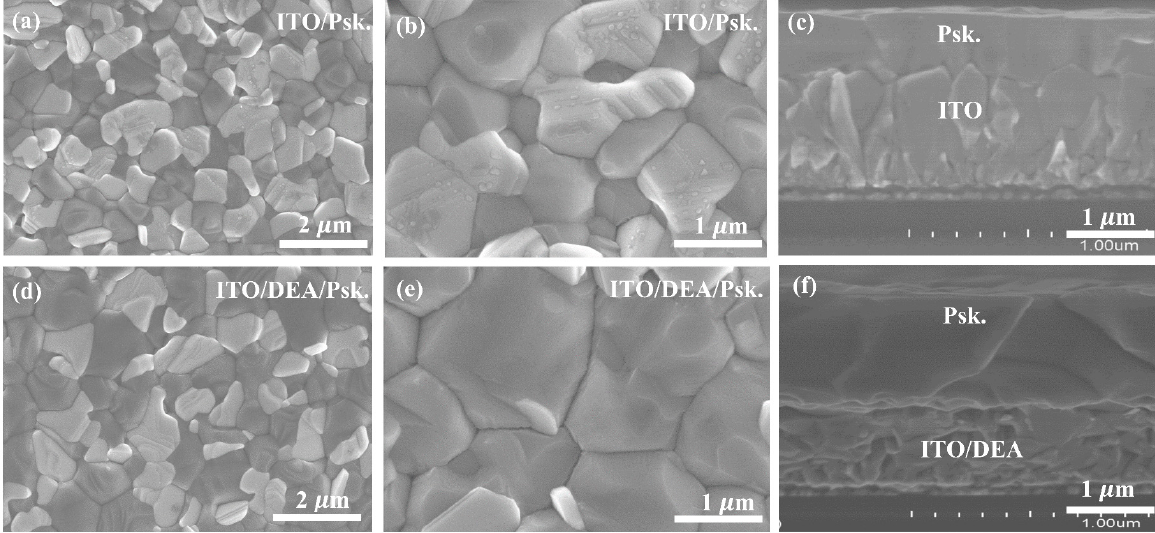
Figure 4. SEM images of the surface and cross-section of the perovskite (Psk.) layers prepared on ITO substrates ( a – c ) and ITO/DEA substrates ( d – f ), respectively. ITO substrates ( a – c ) and ITO/DEA substrates ( d – f ),